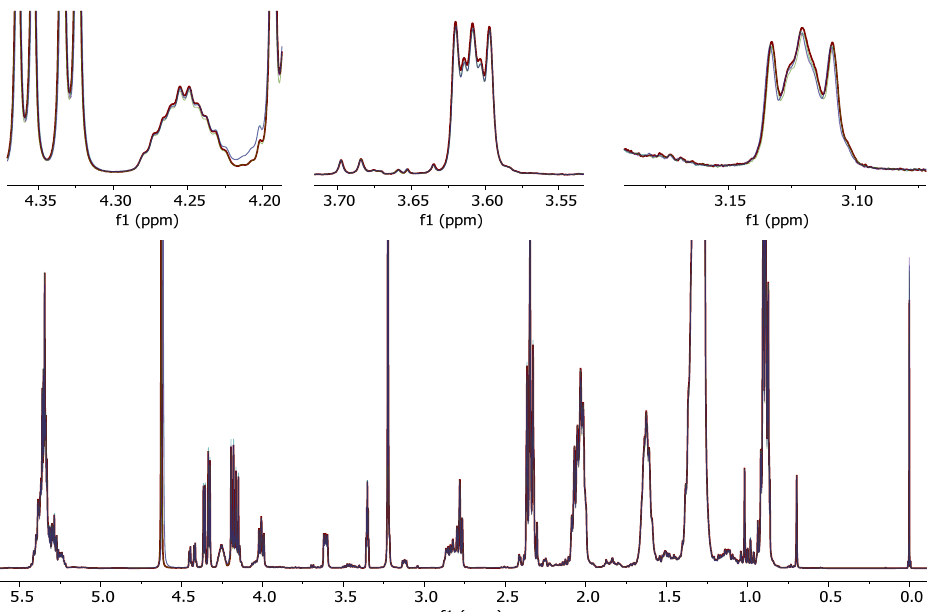
Figure 7. Superposition of four 1 H-NMR spectra of fat extracts of egg yolk samples. Solvent was (D 1 )chloroform (treated with alumina) and (D 4 )methanol (3/2, v / v ). 1 H-NMR spectra, 400 MHz, 290 K, referenced to δ TMS = 0.00 ppm. As described by Ackermann et al. [9], the multiplets at 4.26 ppm and at 3.62 ppm belong to phosphatidylcholine; the multiplet at 3.13 ppm belongs to phosphatidyl- ethanolamine.